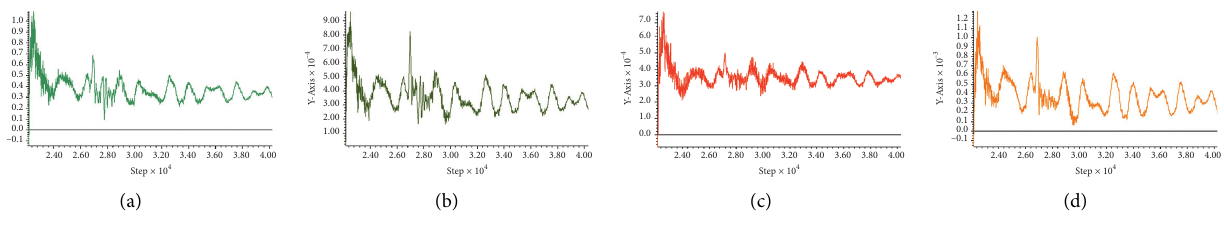
Figure 13: The vibration speed changes when the roadway moves horizontally for 10m: (a) roof, (b) floor, (c) left side, and (d) right side.